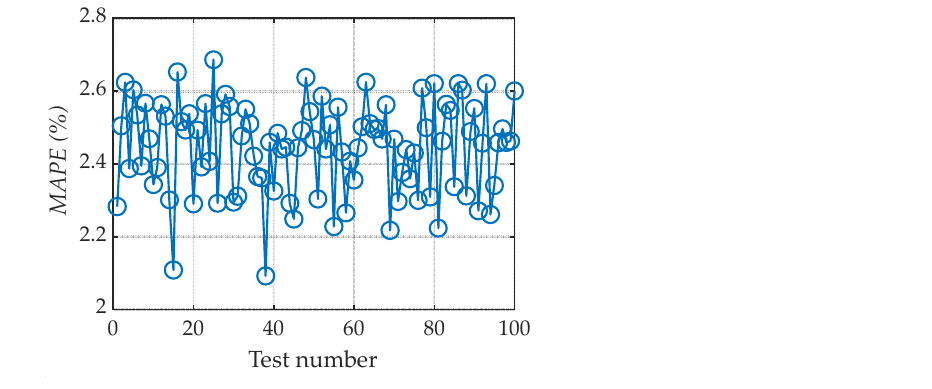
Figure 12. Results of 100 5-fold CV tests of novel method proposed. Note: MAPE is mean absolute percentage error.